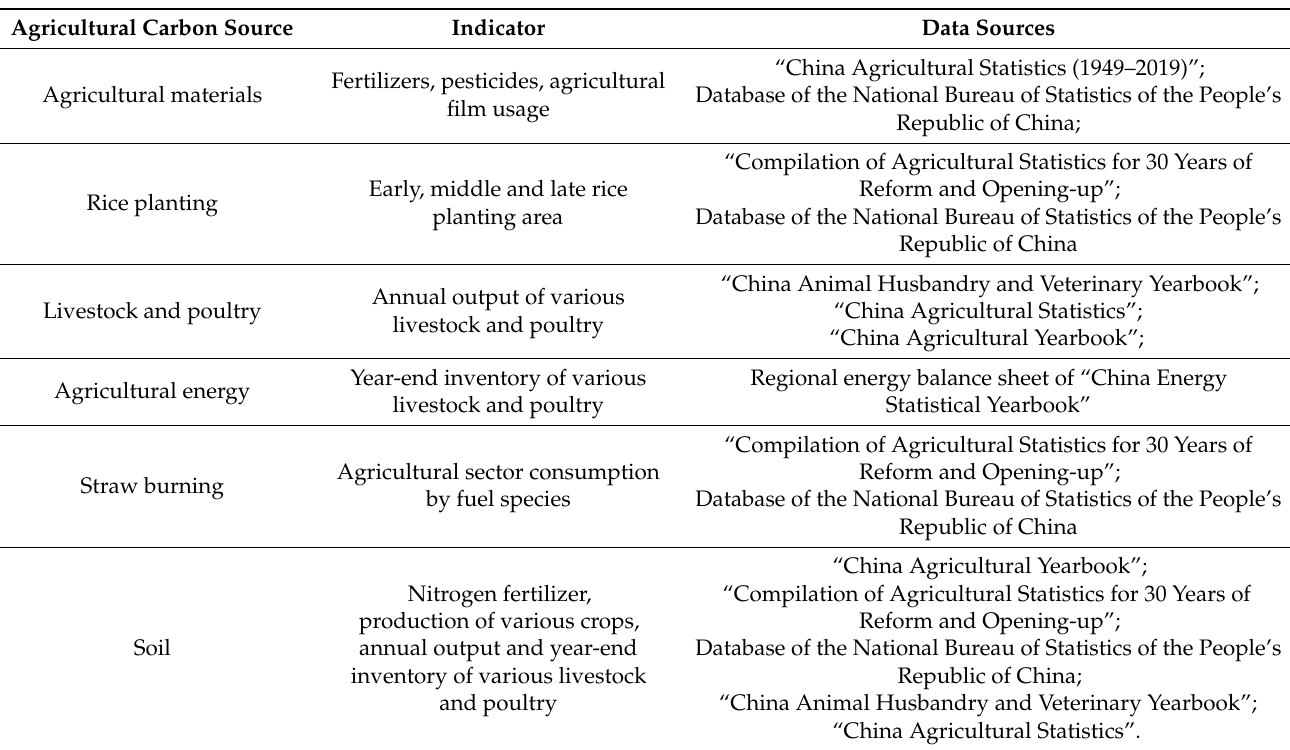
Table 1. Agricultural carbon emissions data